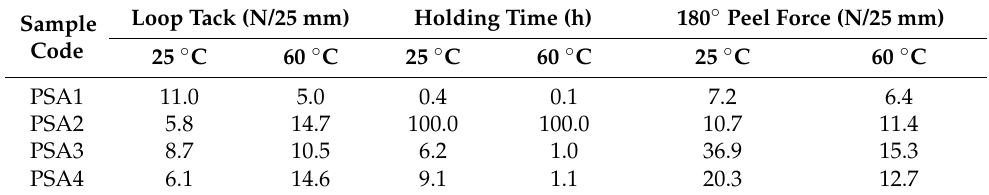
Table 3. Adhesive performances of four WPU-PSAs at 25 and 60 ◦ C, respectively. Sample